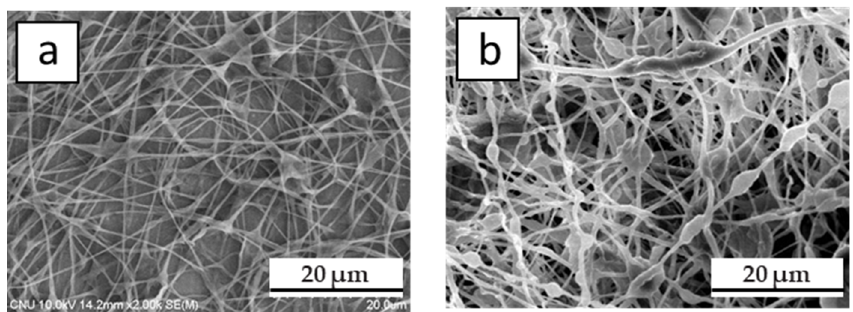
Figure 3. SEM images of electrospun mat under optimized conditions: ( a ) hPB and ( b ) cPB.